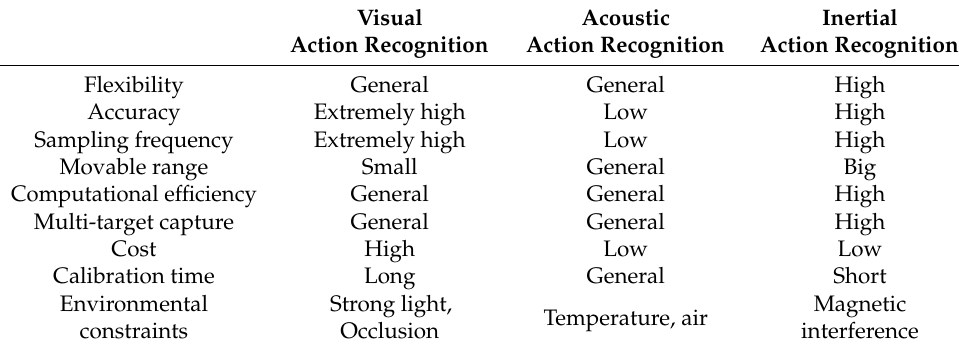
Table 1. Comparison of three action capture